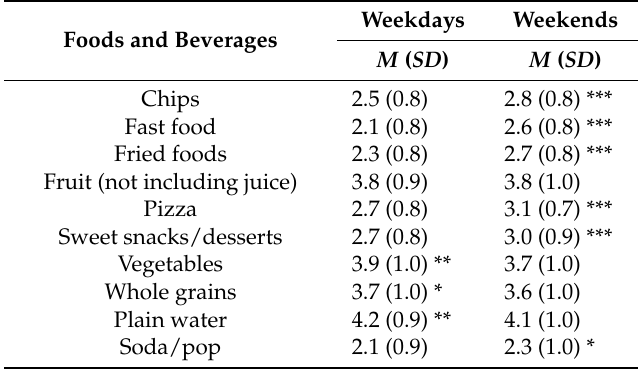
Table 1. Mothers’ Report of Their Child’s Food and Beverage Consumption on Weekdays and Weekends.